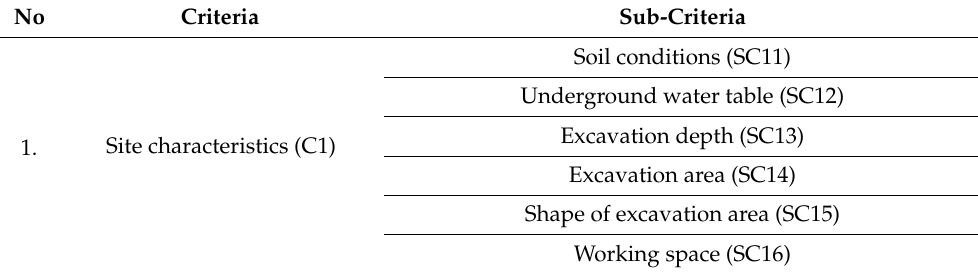
Table 1. Identified criteria and factors affecting them.